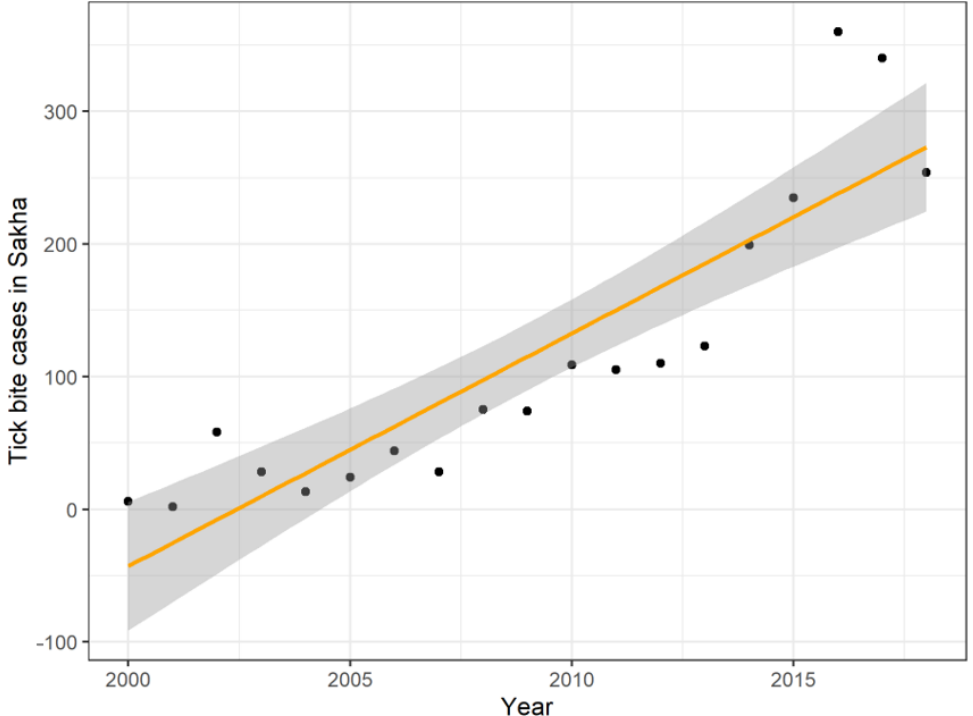
Figure 5. Scatter plot showing the increase in reported tick bite cases between 2000 and 2018 in the Republic of Sakha. The orange line and filled region show a linear regression line and 95% confidence interval. The regression line predicts an increase of 17.5 tick bites per year. Table 1. Regions of the Republic of Sakha (Yakutia), where tick bites were registered for the period between 2006 and 2018. In each cell, the number of cases are reported, with cases per 100,000 shown below it (according to Rospotrebnadzor of the Republic of Sakha).